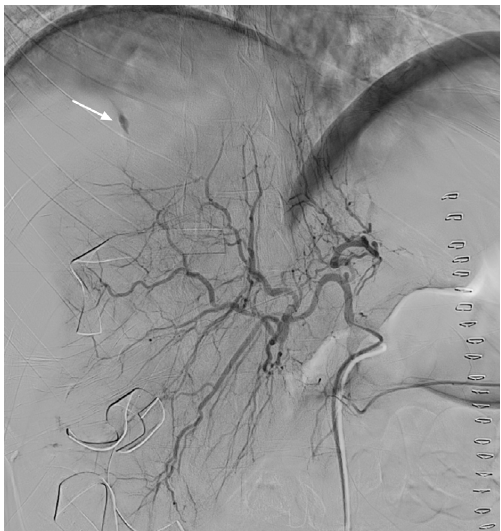
Figure 1. Selective hepatic angiography shows some contrast media extravasation (arrow) in the distal branch of the right hepatic artery.